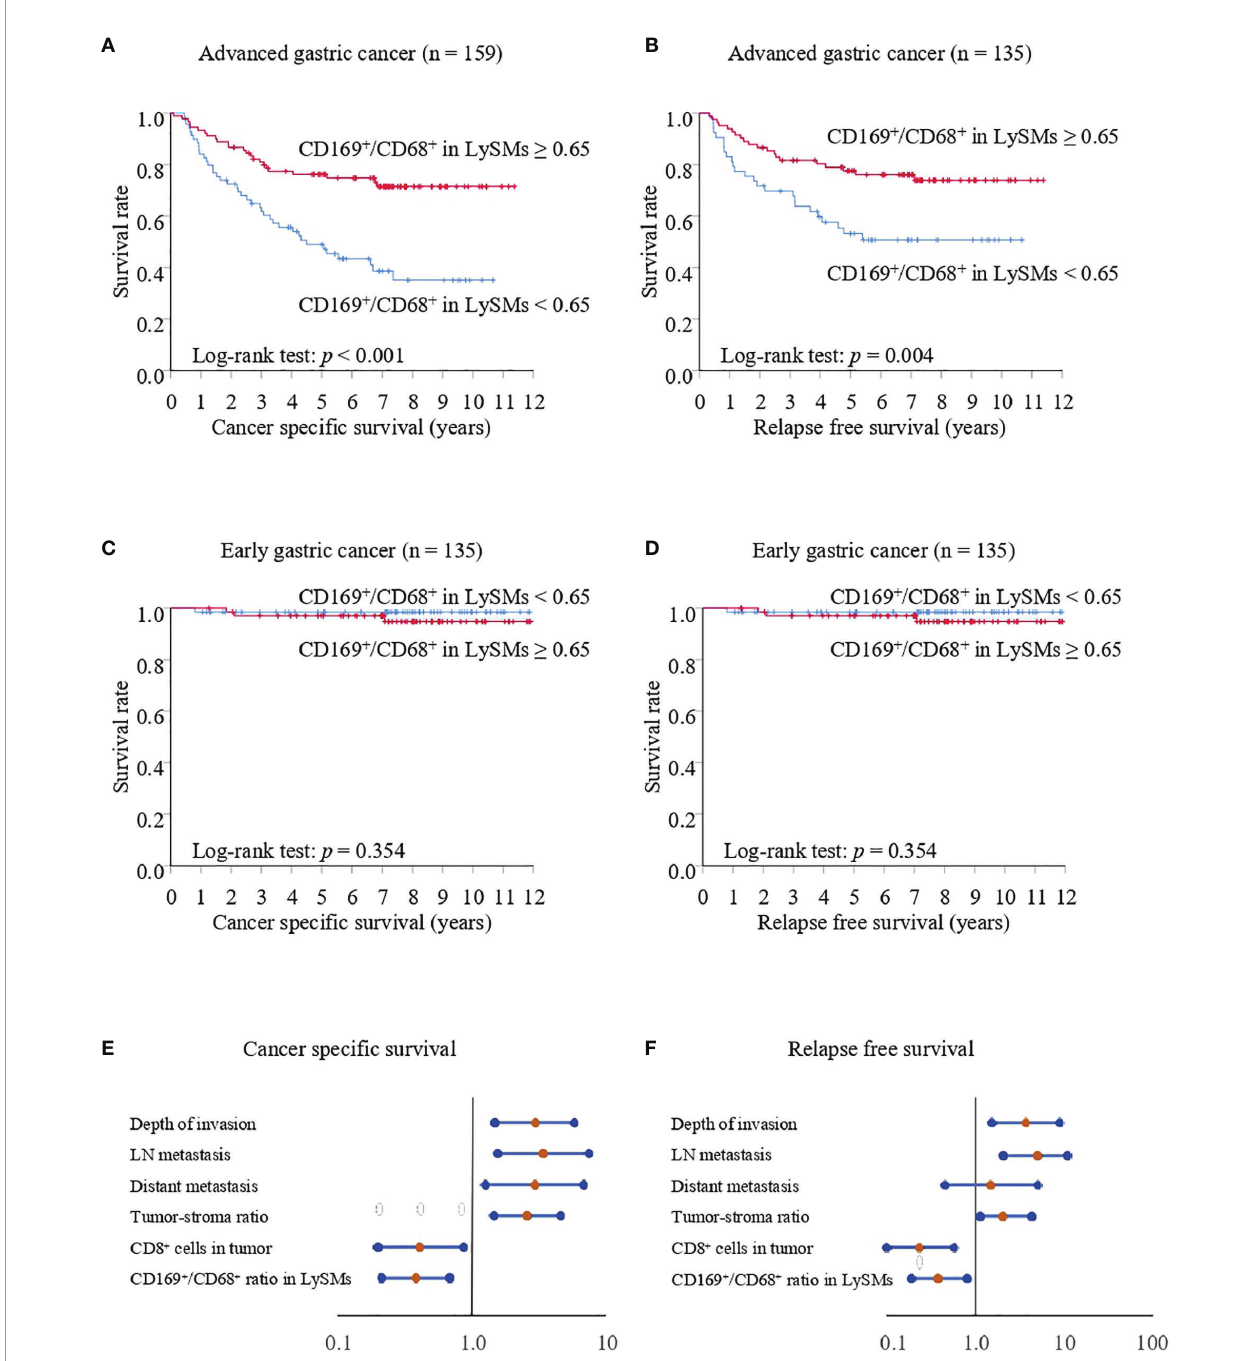
FIGURE 4 | Kaplan-Meier cancer-speci fi c survival and relapse-free survival curves for patients with advanced or early gastric cancer. For all Kaplan-Meier curves, the patients were divided into two groups according to their CD169/CD68 ratio: < 0.65 was de fi ned as low and ≥ 0.65 was de fi ned as high. (A) Cancer-speci fi c survival (CSS) curves for patients with advanced gastric cancer. (B) Relapse-free survival (RFS) curves for patients with advanced gastric cancer. (C) CSS curves for patients with early gastric cancer. (D) RFS curves for patients with early gastric cancer. (E) Forest plot analysis of CSS in advanced gastric cancer. (F) Forest plot analysis of RFS in advanced gastric